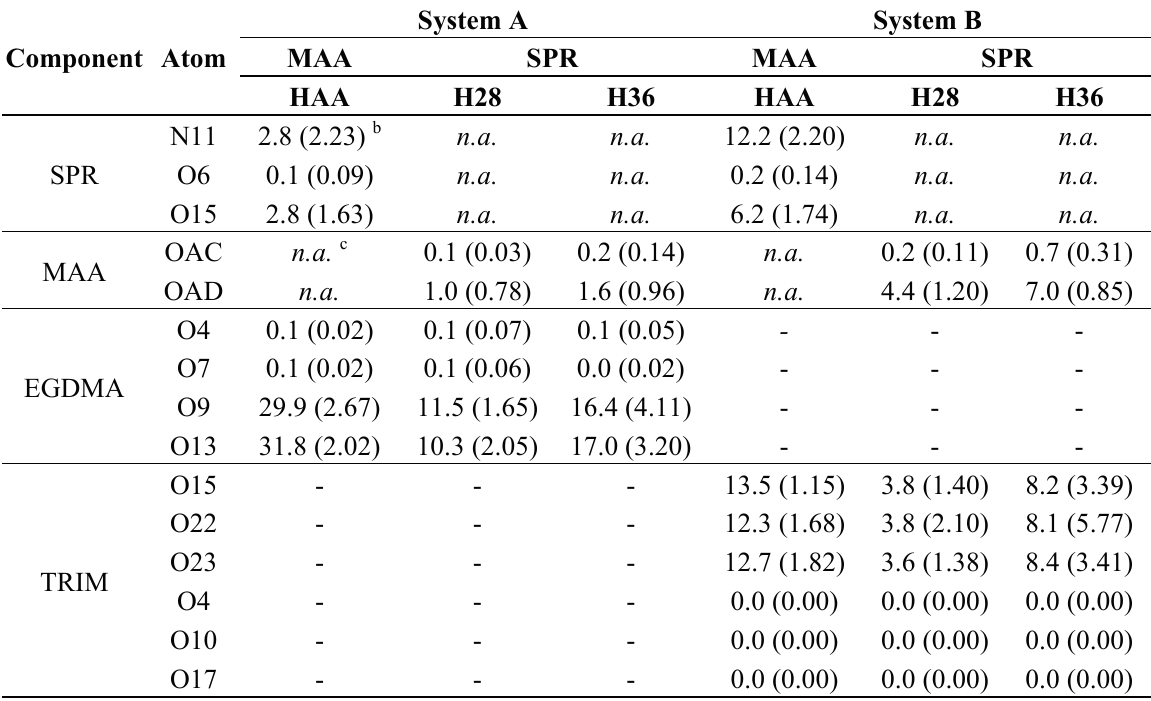
Table 3. Observed average hydrogen bond occupancies a